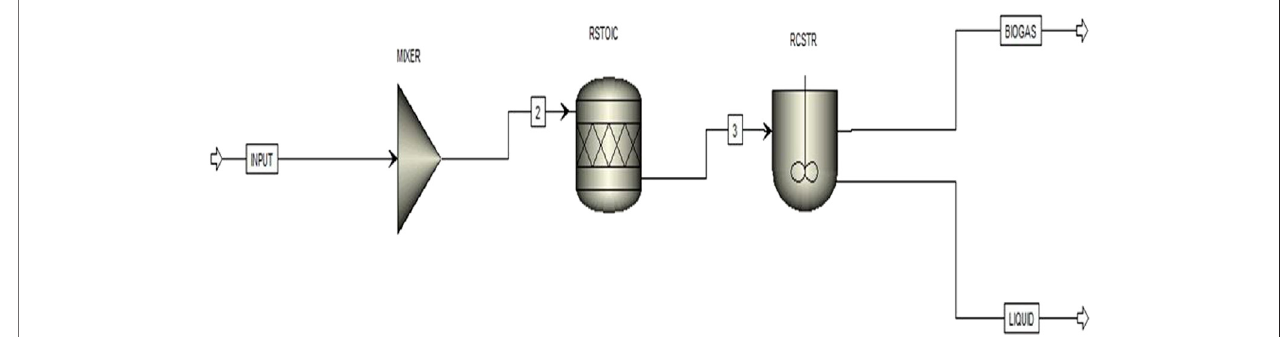
FIGURE 1 | A simulation model for AcoD using Aspen Plus (Inayat et al.,